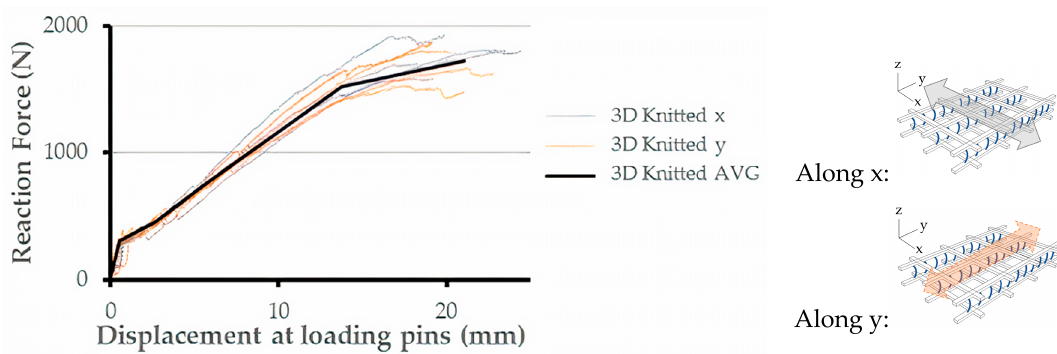
Figure 13. All flexural experimental curves in x- and y-direction for the knitted 3D TRC layup, as well as averaged curve. Table 6. Averaged flexural experimental parameters for the knitted 3D TRC layup. Knitted 3D TRC, all specimens, Vf = 1.49% Along x: